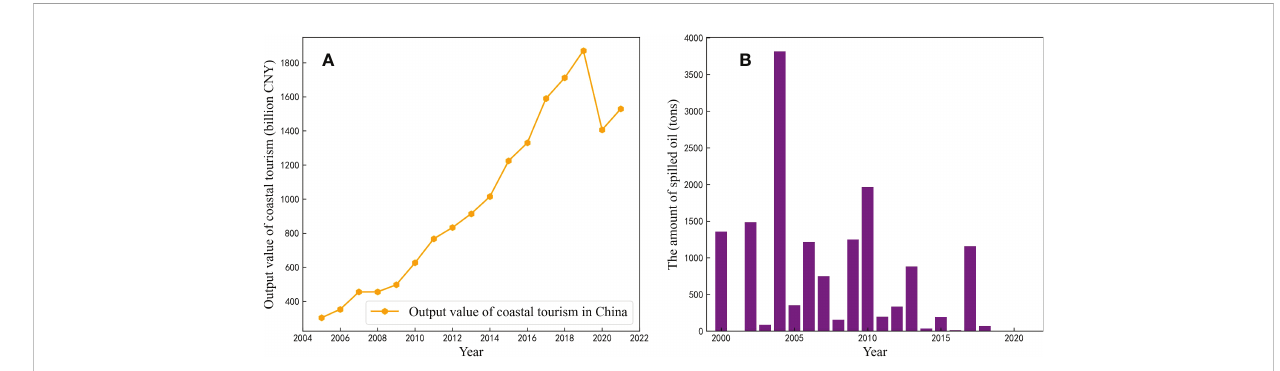
FIGURE 8 (A) Annual output value of coastal tourism from 2005 to 2021 in China. (B) The volume of oil spilled annually from 2000 to 2021 (data for 2001